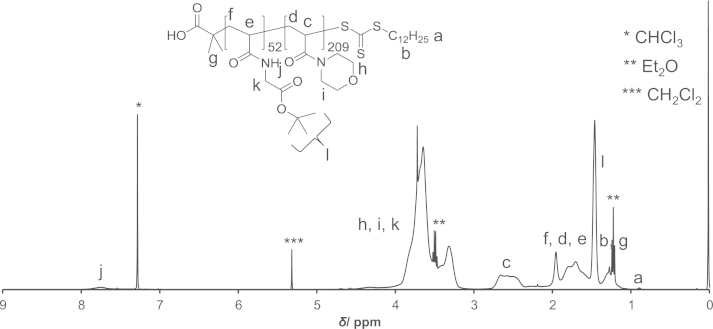
1H NMR spectrum of polymer (5).